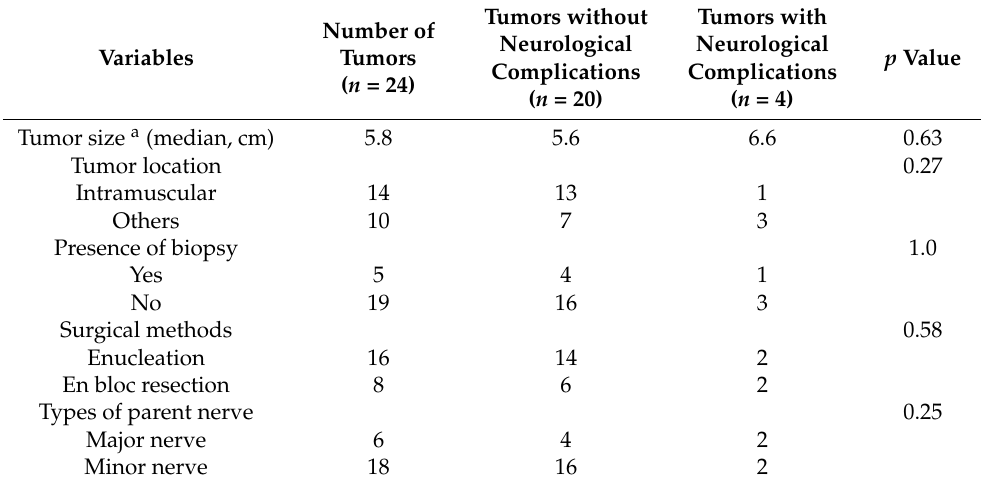
Table 3. The association between clinical variables and postoperative neurological complications in 24 nodular plexiform